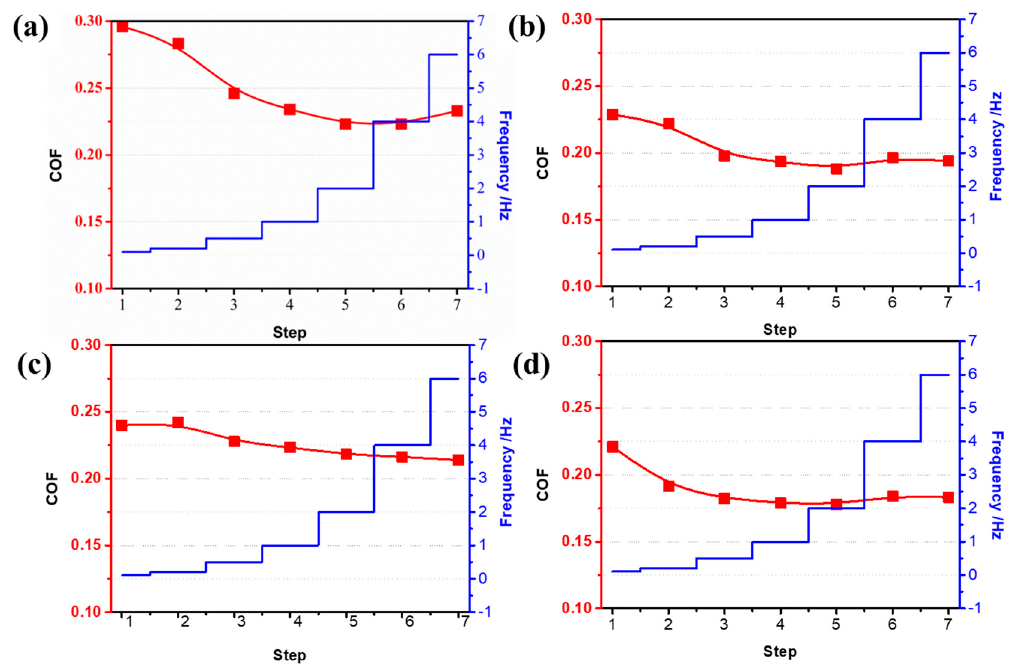
Figure 7. The curve graph of the average COF with different sliding speeds, ( a ) CoCrMo, ( b ) Co-T, ( c ) Co-S, and ( d ) Co–T–S.